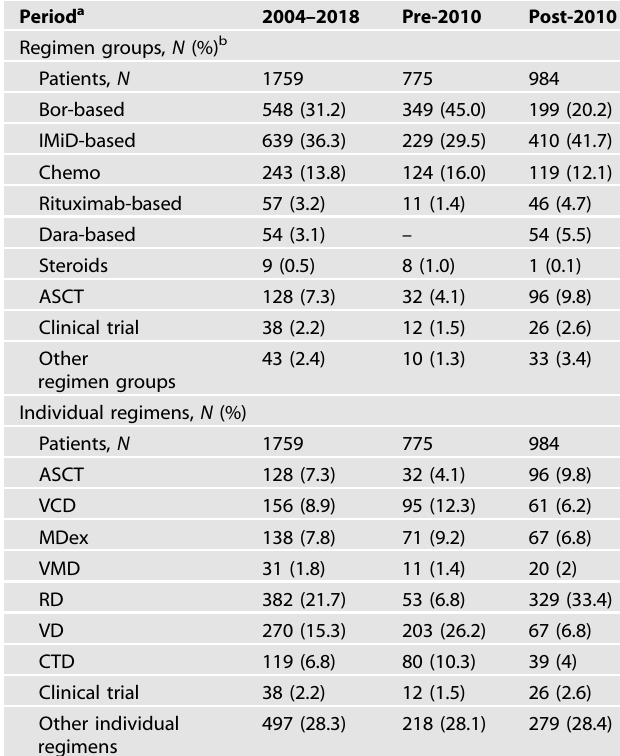
Table 2. First-line treatment regimens, overall (2004 – 2018), and by fi rst-line treatment initiation period (pre- and post-2010).